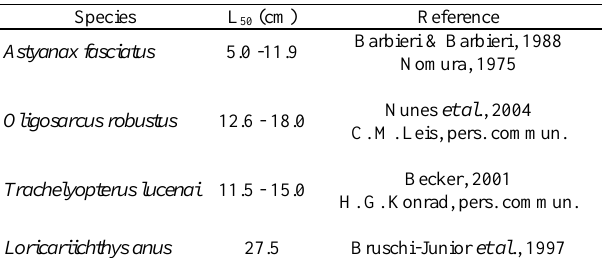
Table 1. Available information concerning the size at first maturation for the fish species under